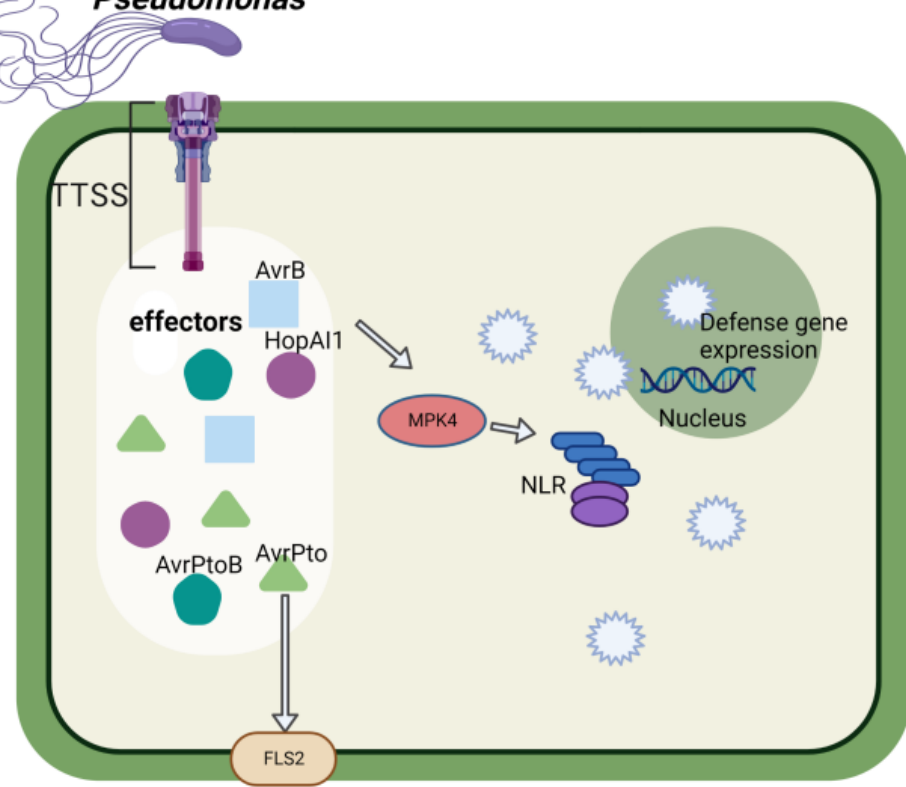
Figure 2. Schematic diagram of soybean immune response to effectors secreted by Pseudomonas . Pseudomonas secretes effectors into soybean cells to promote virulence and symbiosis. These effec-